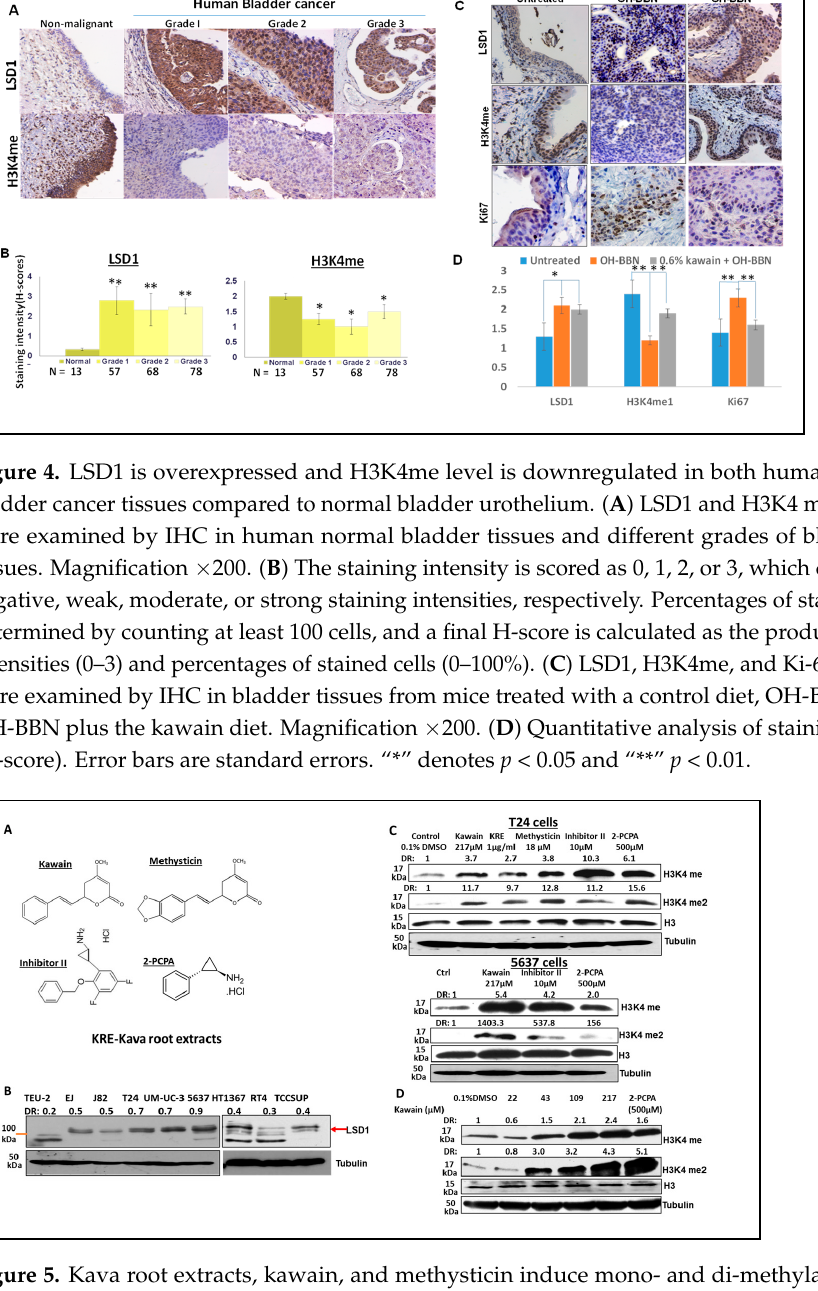
Figure 6. The kawain diet reverses the effects of OH-BBN on the expression of LSD1 target genes. ( A ) RNAs were extracted from bladder tissues of untreated, exposed to OH-BBN only, or OH-BBN plus the kawain diet mice. ( B ) Real-time RT-PCR was performed to analyze the mRNA expression of LSD1 target genes (PSA and TMPRSS2). Bars are the means ± SD of three independent experi- ments. The differences in mRNA expression levels were compared between OH-BBN only treat- ment and untreated or OH-BBN plus kawain-treated mice ( n = 6 in each group). “**” denotes p < 0.01.